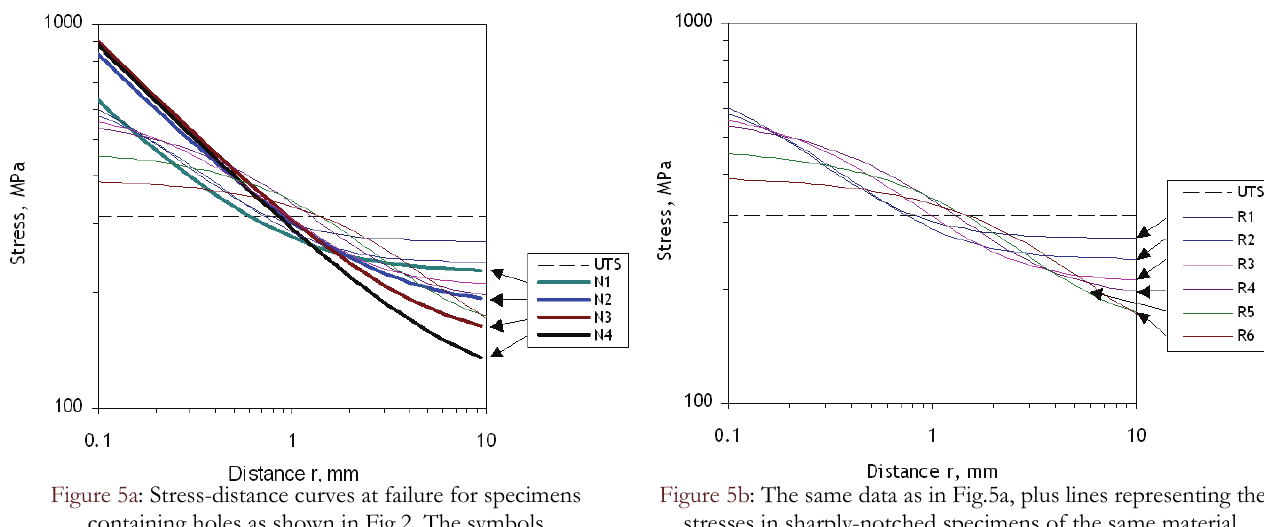
Figure 5a: Stress-distance curves at failure for specimens containing holes as shown in Fig.2. The symbols R1-R6 indicate increasing hole radius.